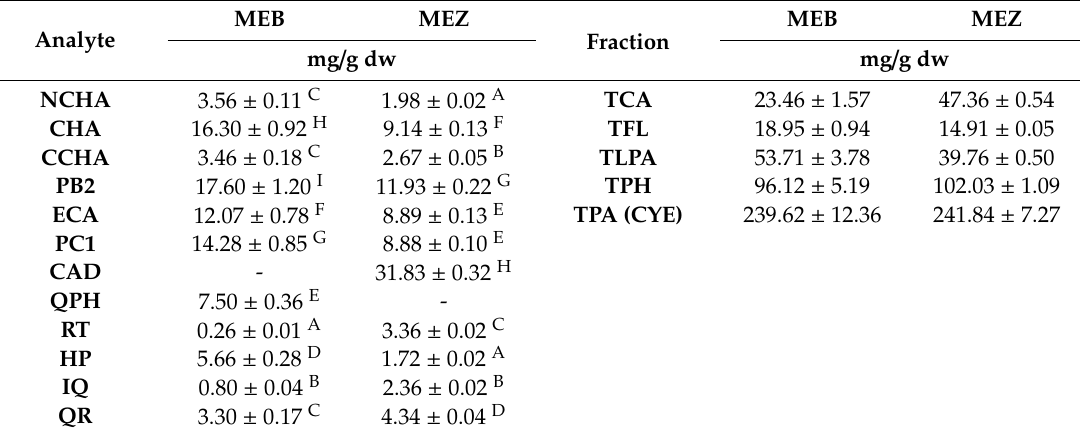
Table2. Thequantitativeprofileofthemethanol-water(7:3, v / v )extractsof C.bullatus and C.zabelii leaves.